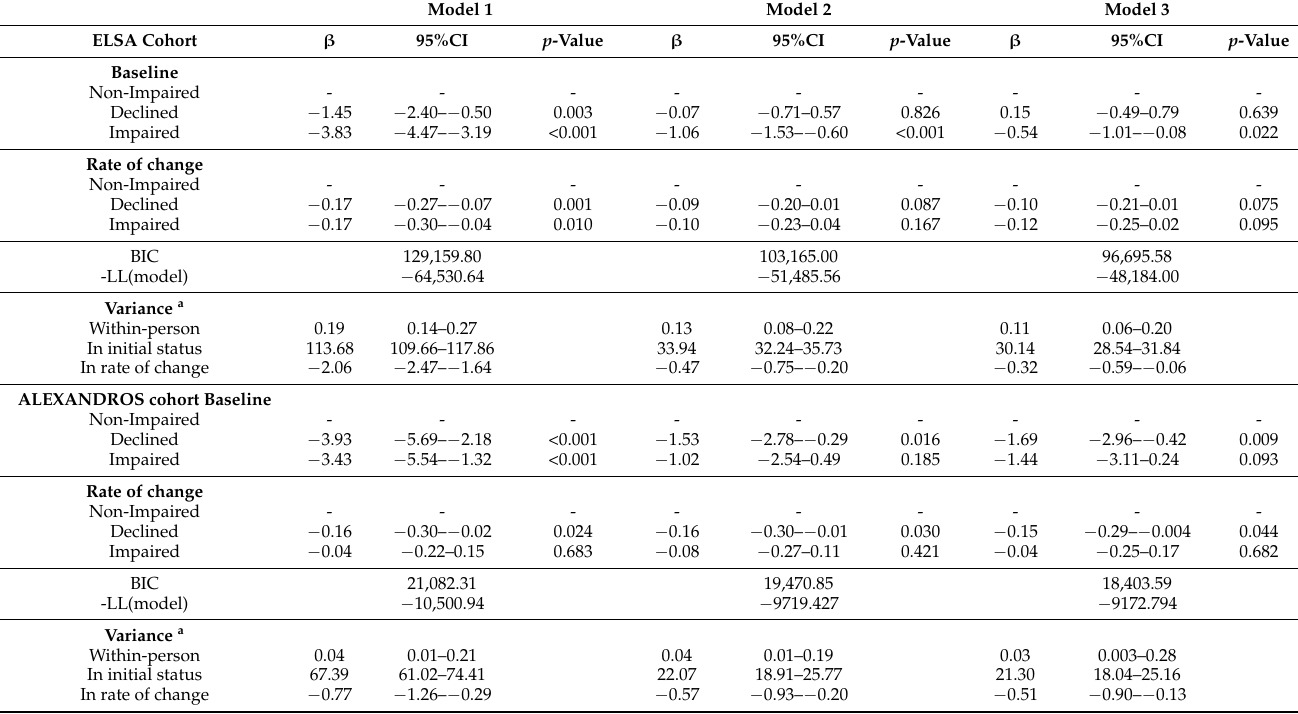
Table 4. Linear mixed models for grip strength trajectories for ELSA and